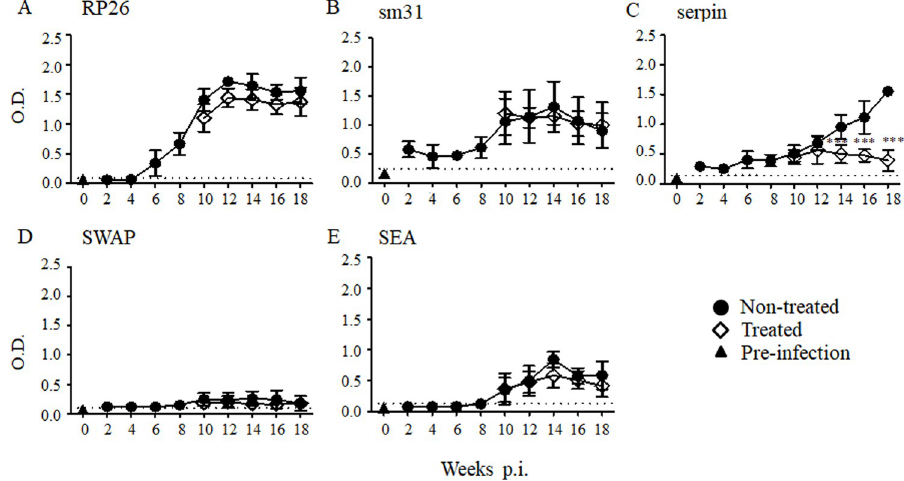
Fig 4. IgE responses to the S . mansoni antigens RP26, sm31, serpin, SEA and SWAP during S . mansoni infection and after the treatment. Five mice were infected with 50 S . mansoni cercariae, and the sera were collected from five mice at each time point. A group of mice was orally treated twice with 500 mg/kg PZQ at 8 weeks post-infection. The experiment was repeated for 3 times. The means of the IgE level to the S . mansoni recombinant RP26 (A), sm31 (B), serpin (C), and crude SWAP (D) and SEA (E) are shown with the standard errors. The dashed line represents the cut- off value (mean + 3SD of the OD of the pre-infected group). IgE levels of the treated group (open diamonds) were compared with those of the untreated group (closed circles) and with those of pre-infection samples taken at week 0 (closed triangles). �� p < 0.01 and ��� p <